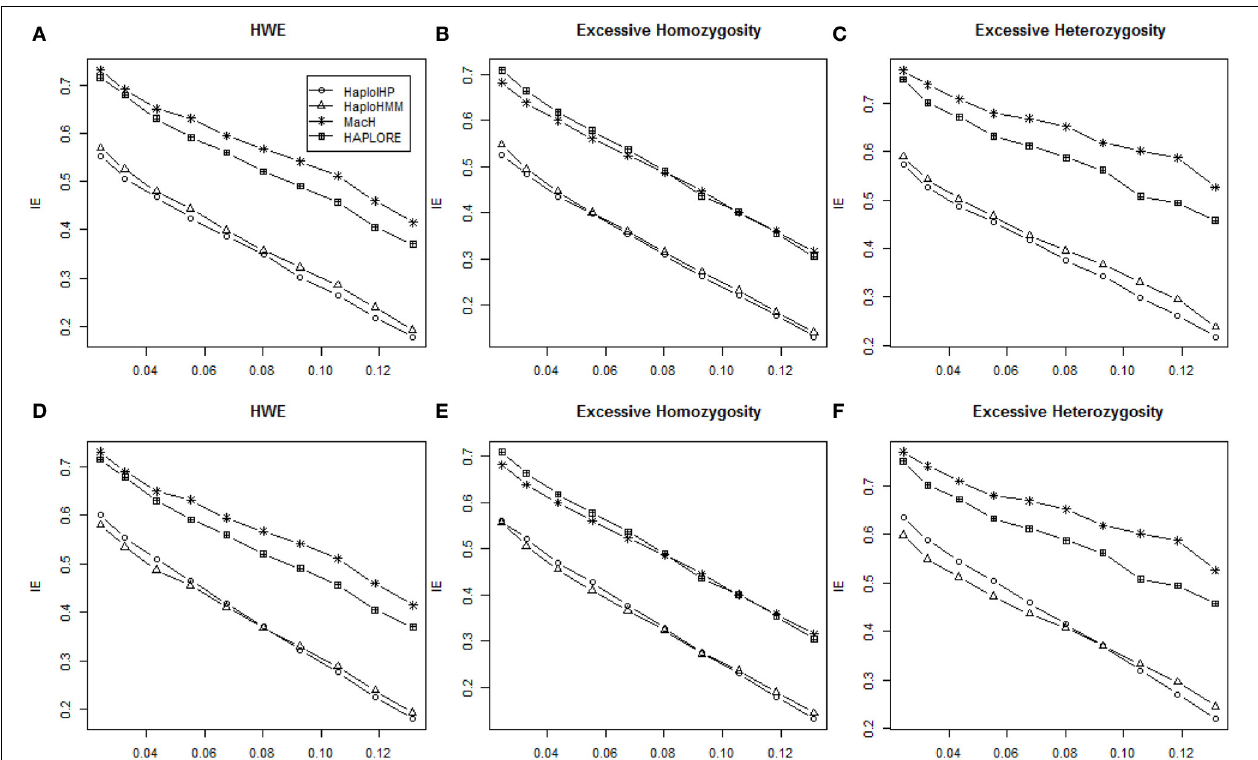
FIGURE 4 | Average values of IE with the sample size of 100 and with HWE, excessive heterozygosity, and excessive homozygosity. The x-axis represents the standard deviation of haplotype frequencies used in